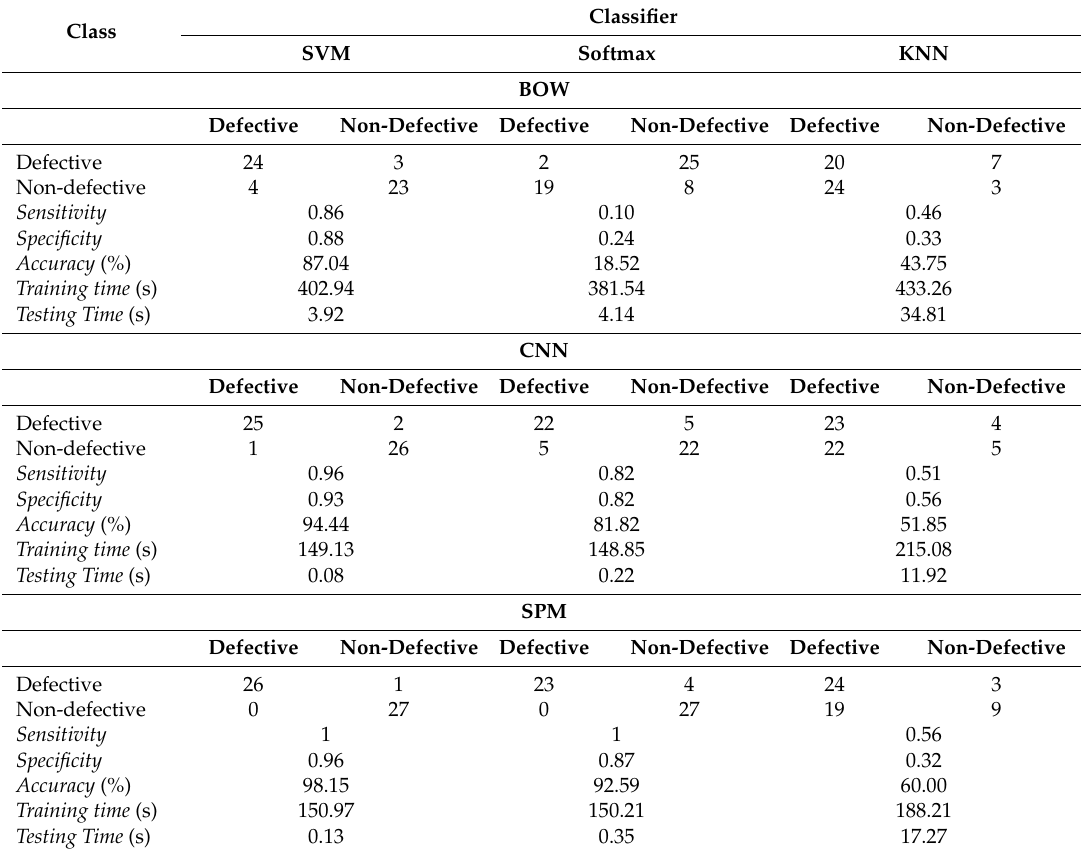
Table 3. Comparison of confusion matrix for BOW, CNN and SPM method with different